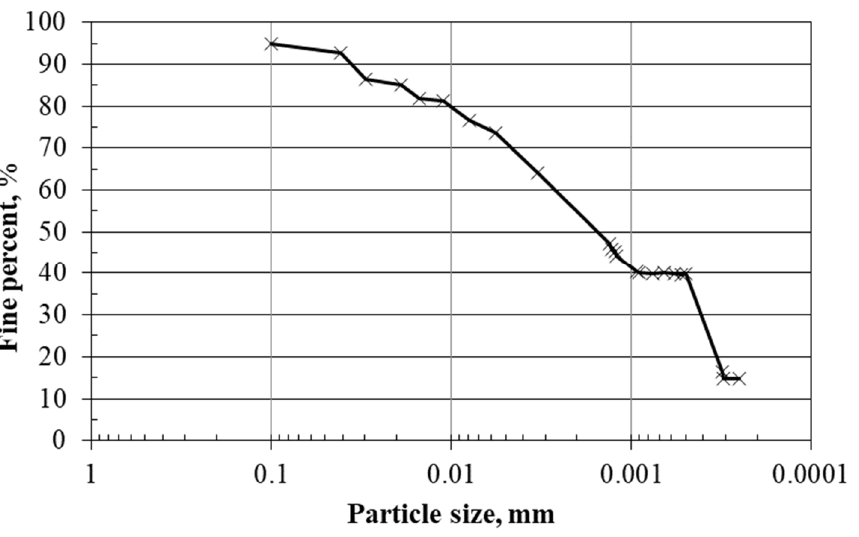
Figure 1. Hydrometer analysis of Al-Qatif clay.